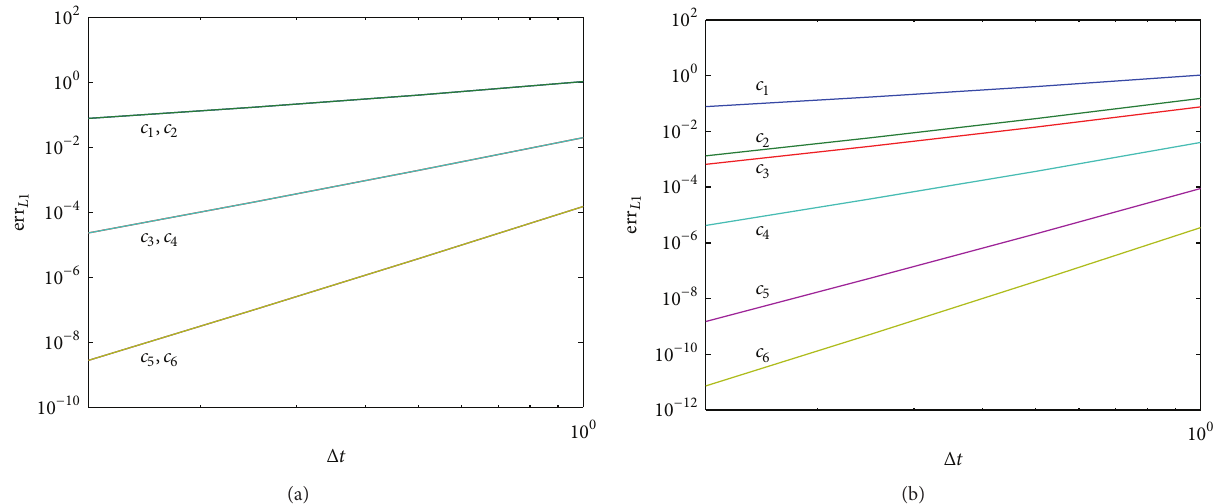
Figure 9: Numerical errors of the one-sided and two-sided splitting schemes for an optimised approach: one-sided splitting over 𝐴 (a) and two-sided splitting scheme alternating between 𝐴 and 𝐵 (b) with 1, ...,6 iterative steps.